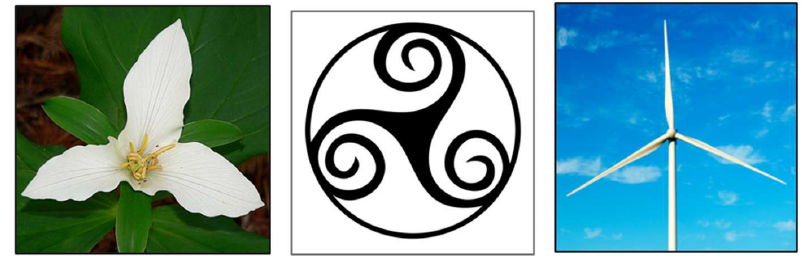
Figure 1. Left to right: Trillium ovatum flower; celtic symbol triskell;